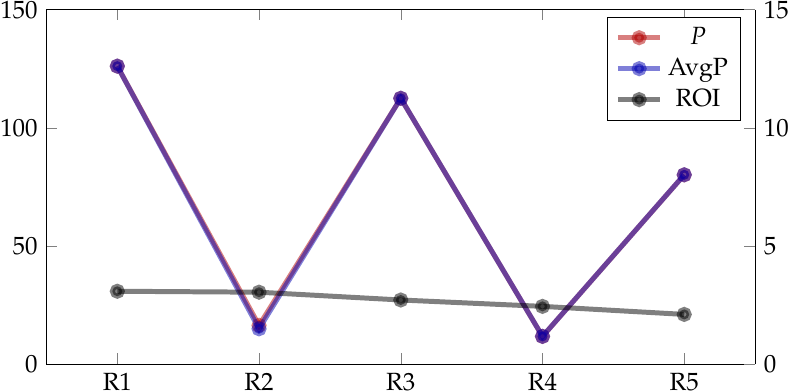
Figure 3. Values of P (left axis) and AvgP and ROI (right axis) indicators obtained using 5 best-rated rules determined to maximize ROI